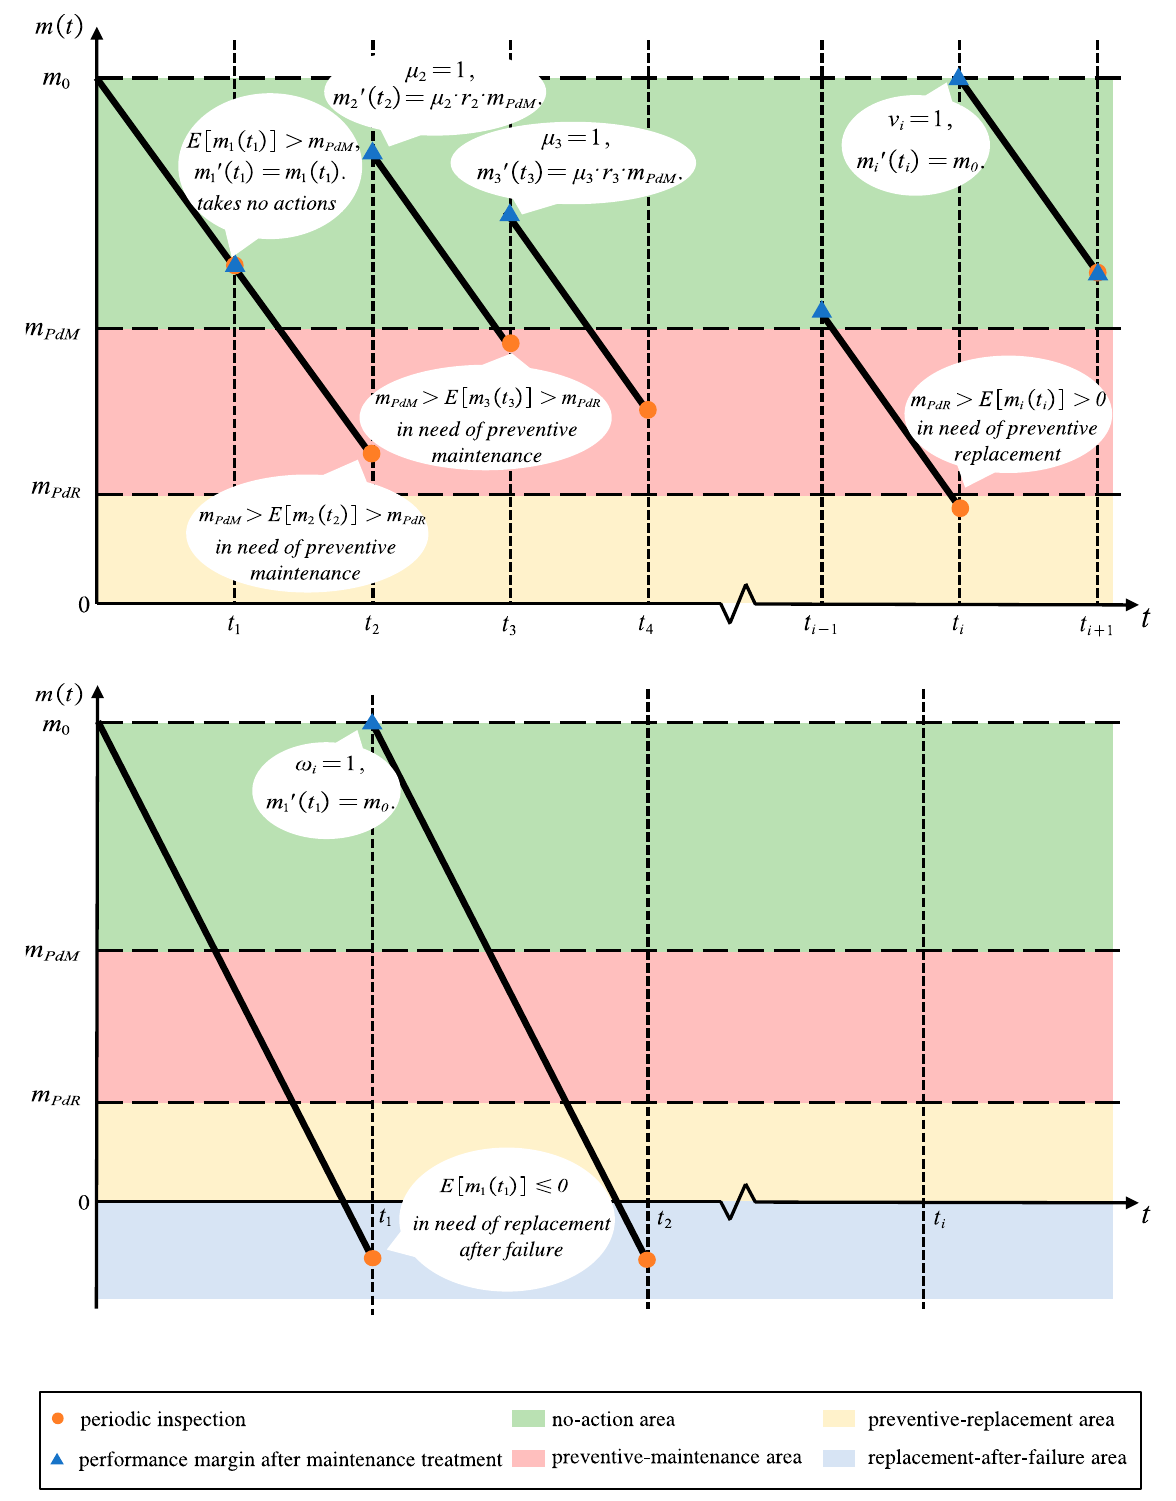
Figure 2. Illustration of the maintenance-involved degradation process.